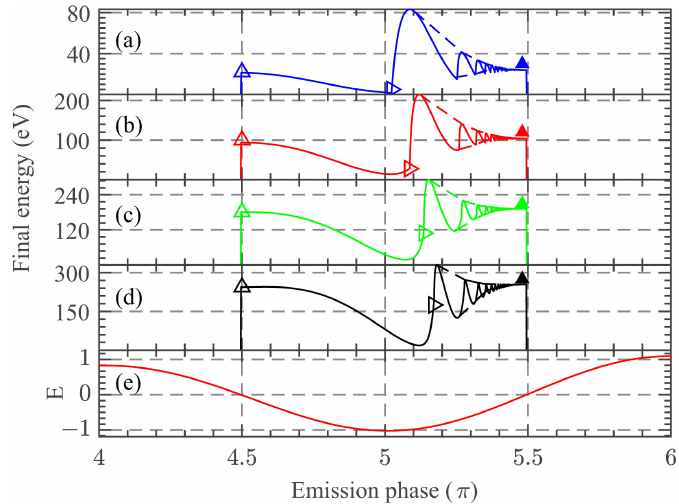
Figure 6. (color online) Dependence of the photoelectron final energy on the emission phase (tunneling time) for different laser wavelengths. ( a ) extracted final electron energies at a laser wavelength λ = 800nm, ( b ) λ = 1600nm, ( c ) λ = 2400nm and ( d ) λ = 3200nm. The rest of the laser parameters are the same as those used in Figure 3. Considering that the tunneling probability is strongly dependent of the laser electric field, only the results from the cycle which contain the laser peak intensity are shown. The figure sizes of ( a – d ) are the same and the limit of the four vertical axes corresponds to the maximum final energy. In ( e ), we plot the normalized laser electric field as a function of the emission